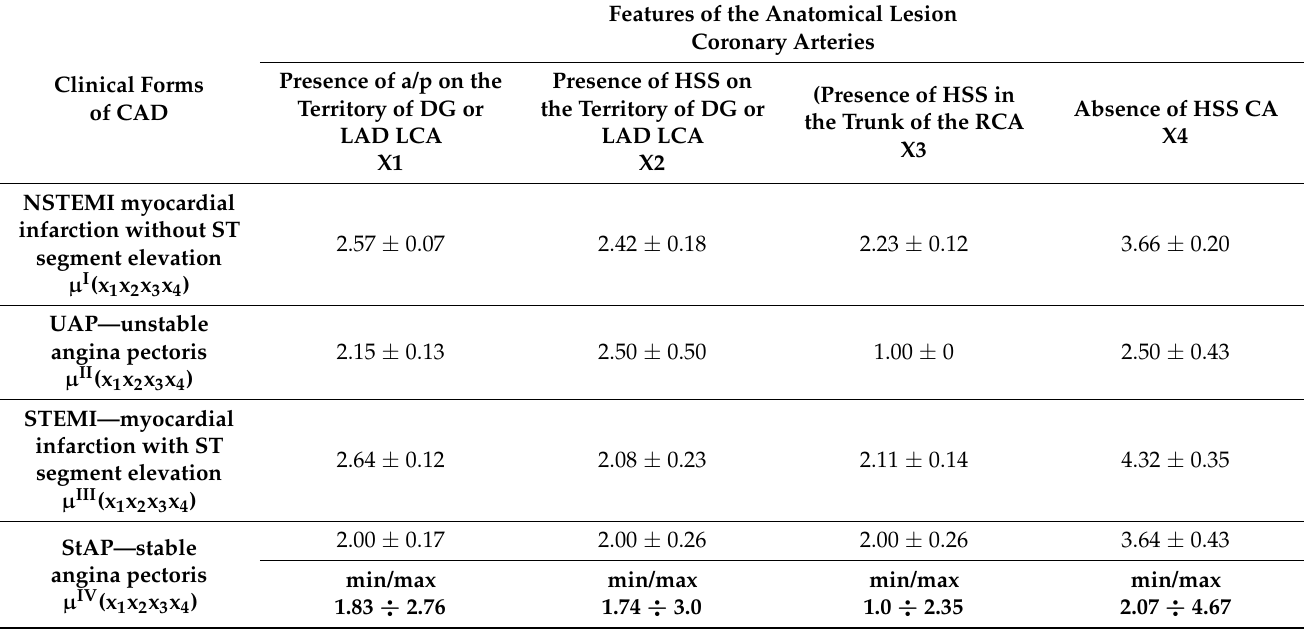
Table 3. Features of the anatomical lesions of the coronary arteries in patients with various forms of